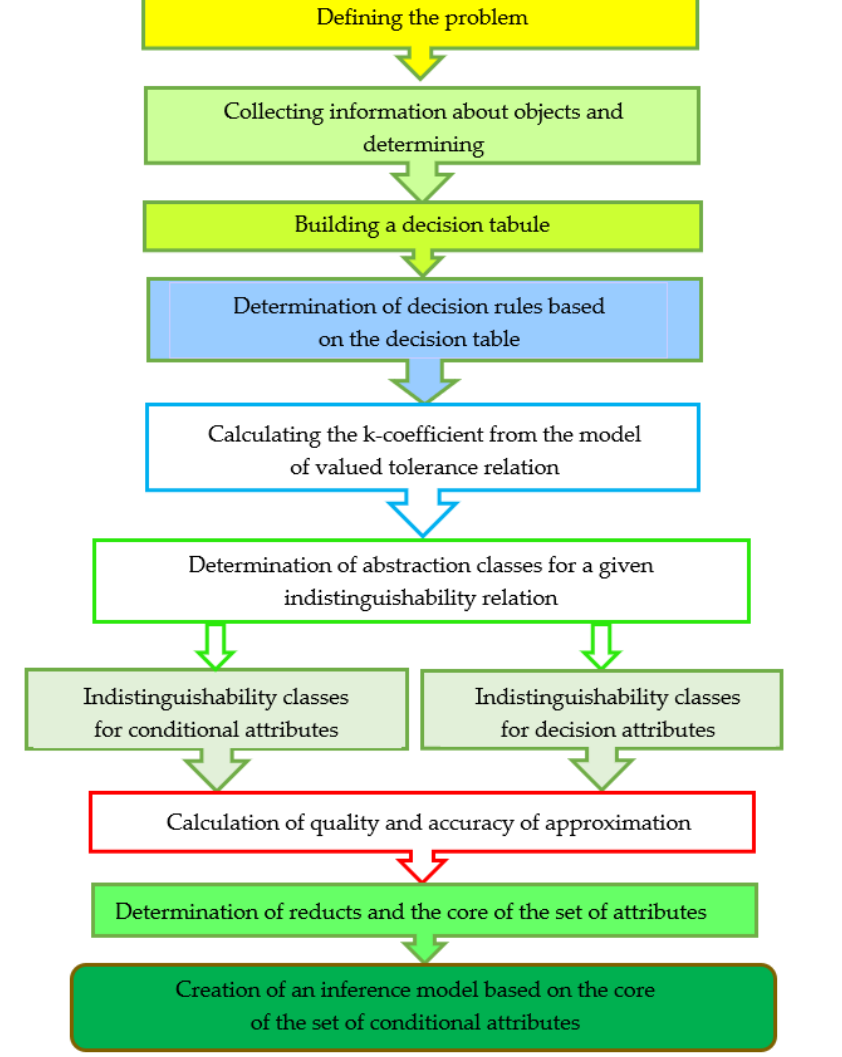
Figure 3. Scheme for building an inference model based on the core of a set of conditional attributes using rough set theory (RST).